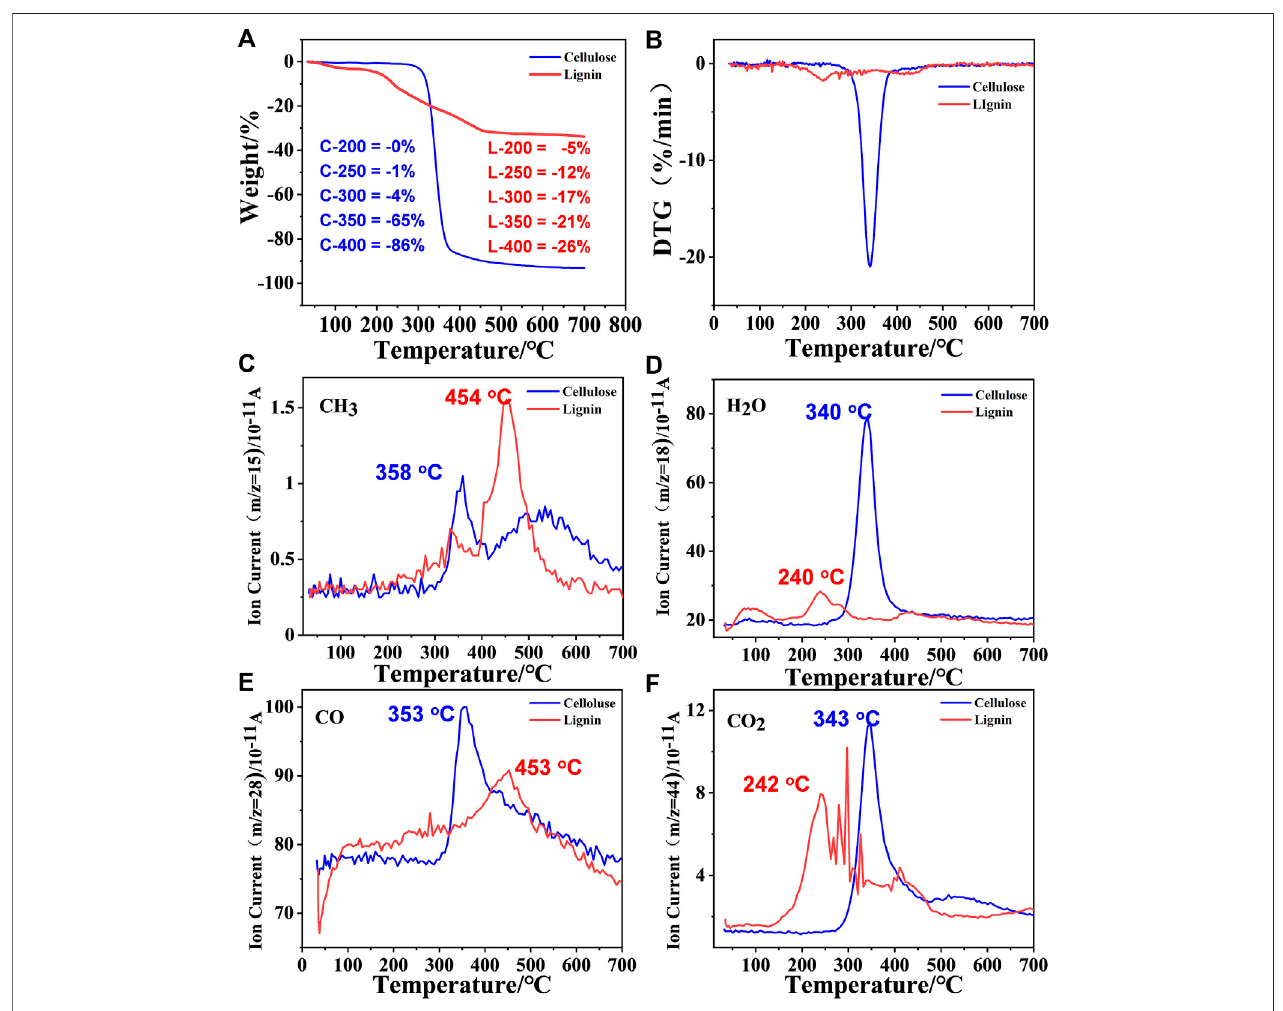
FIGURE 2 | (A,B) TG/DTG curve of cellulose and lignin. (C – F) The evolutions of gaseous product for the two components at 10 ° C min − 1 .